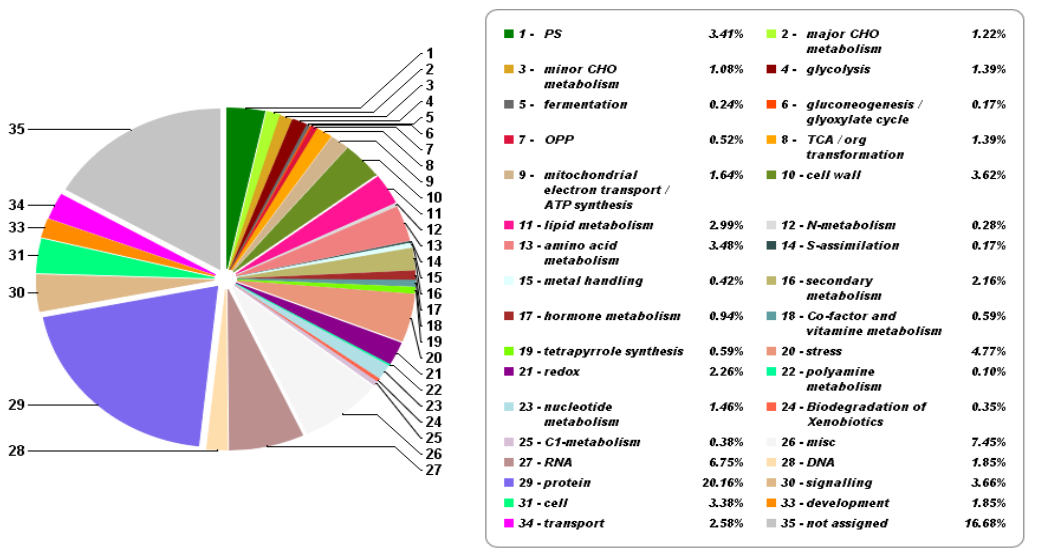
6 of 22 Figure 5. Fold change of selected guard cell-specific proteins in guard cell samples compared to